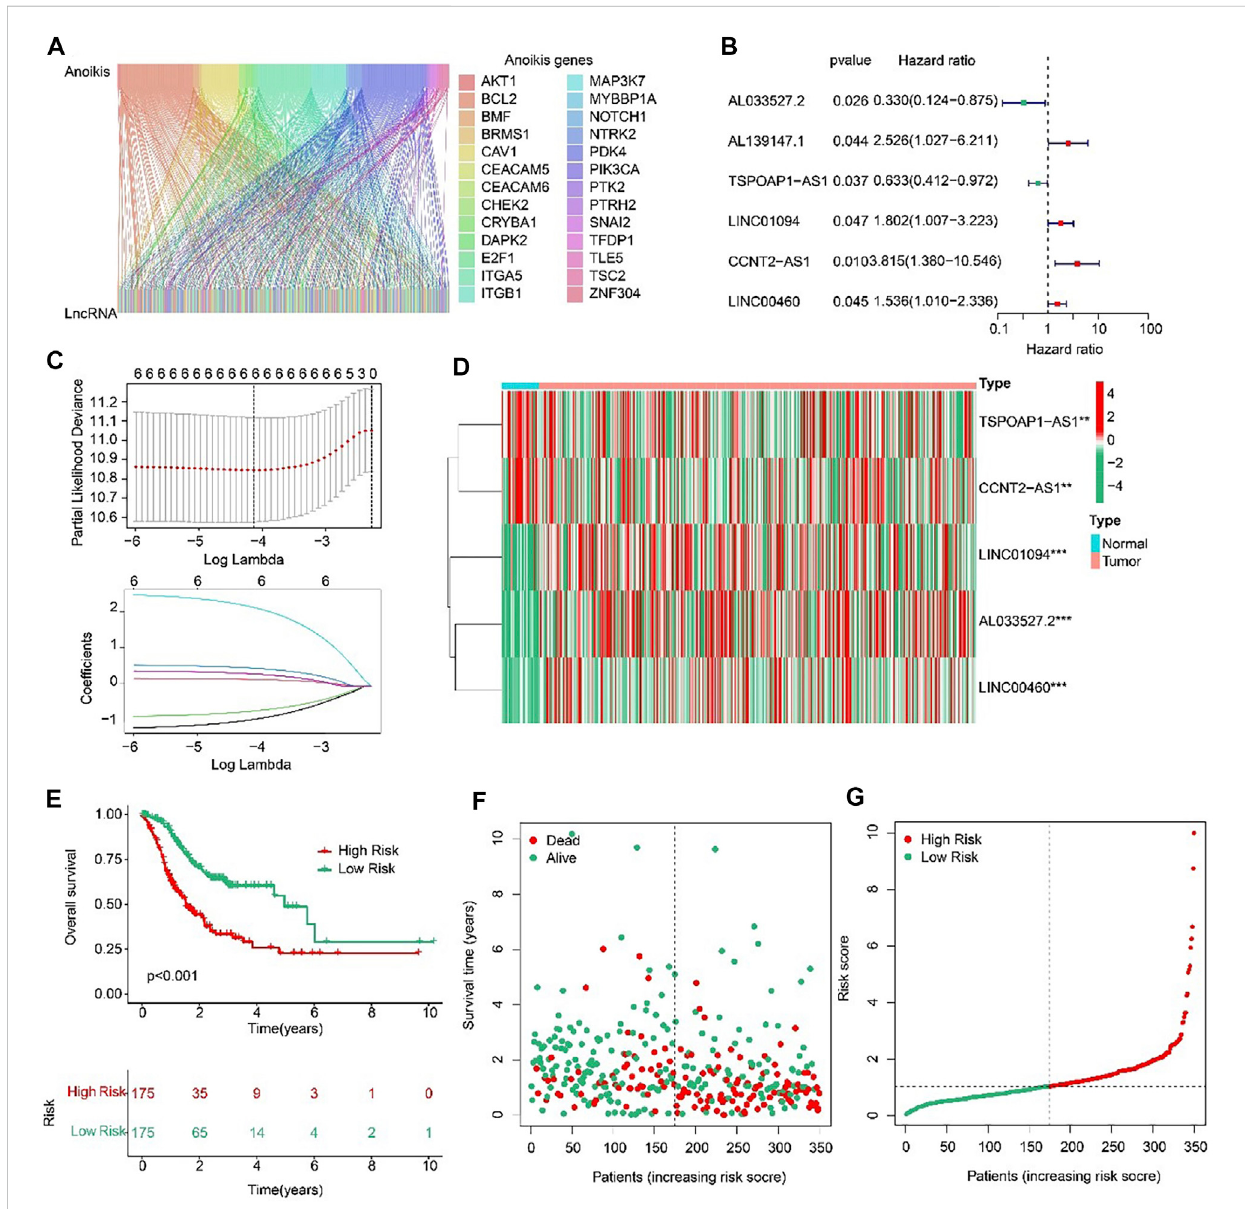
FIGURE 2 RiskmodelconstructionbasedontheprognosticARLsinSTAD. (A) TheSankeydiagrampresentsthedetailconnectionbetweenARGsandARLs. (B) Univariate Cox regression analysis of ARLs. (C) LASSO regression analysis shows the minimum lambda and optimal coef fi cients of prognostic ARLs. (D) Heatmapof fi veprognosticARLsinnormalandtumorgroups. (E) TheKaplan-MeiersurvivalcurveoftheOSrateinSTADpatientswithdifferentriskscore. (F, G) The classi fi cation of the STAD patients according to the ARLs risk model and the scatter dot plot shows the correlation of the ARLs prognostic signature and survival